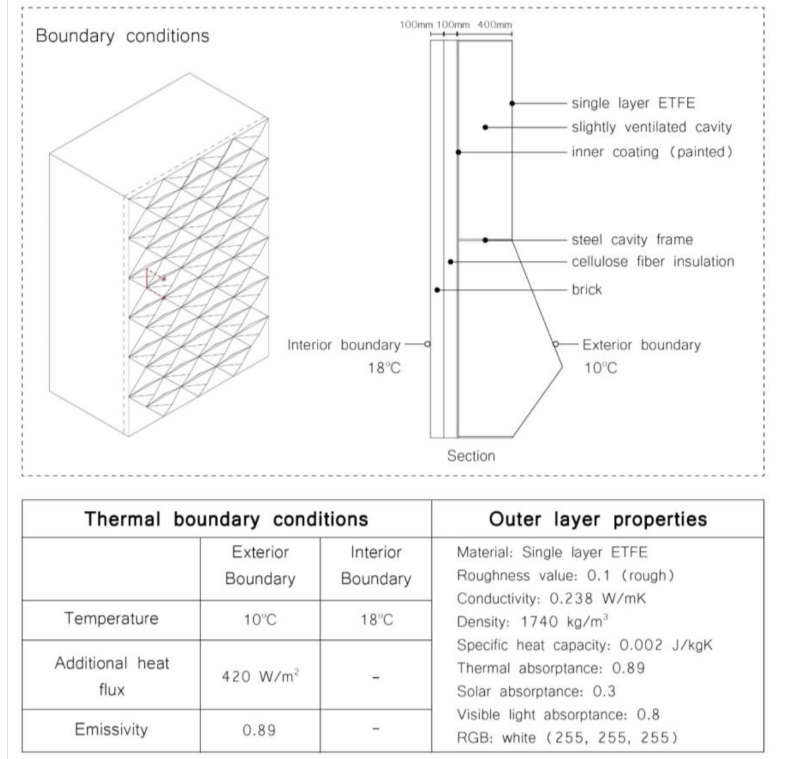
Figure 14. Overview of the input parameters and boundary conditions for the THERM